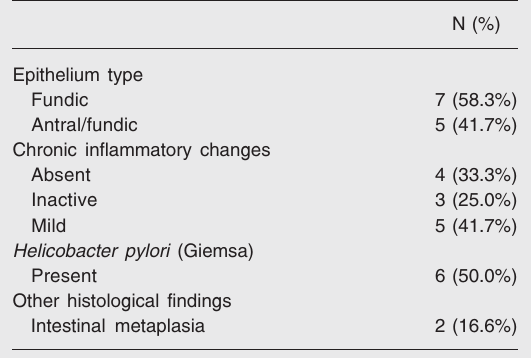
Table 1. Histological characteristics of ectopic gastric mu- cosa.